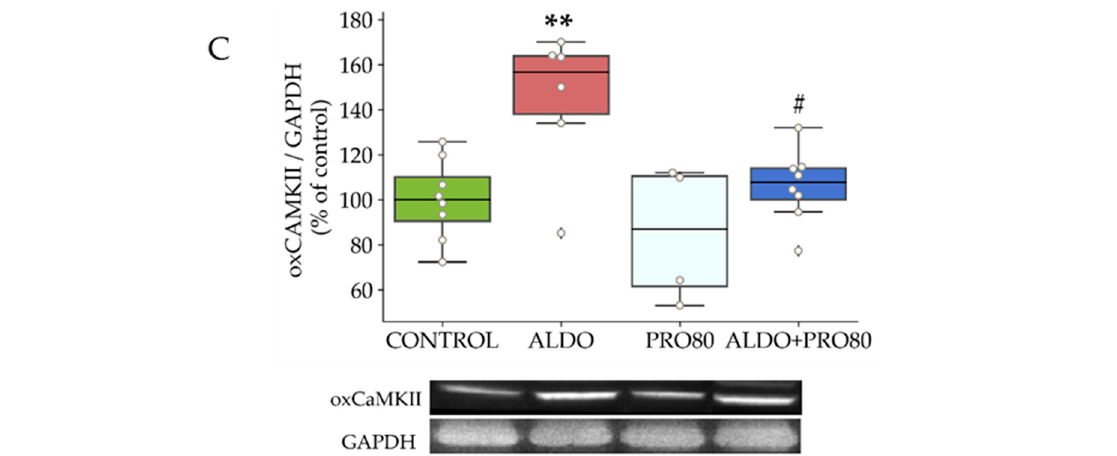
Figure 4. Effect of aldosterone and PRO80 treatment on myocardial protein expression of CAMKII, pCAMKII and oxCAMKII. Relative protein expression levels of Ca 2+ /calmodulin-dependent protein kinase II by western blot. ( A ): Total CaMKII, ( B ): Phosphorylation in threonine 286 (pCaMKII), ( C ): Oxidation in methionines 281 and 282 (oxCAMKII). The boxplots show median, first and third quartile, and minimum and maximum values; the dots show individual values.* p < 0.05 vs. control; ** p < 0.01 vs. control; # p < 0.05 vs. ALDO; ## p < 0.01 vs. ALDO. CONTROL: Control group; ALDO: Aldosterone-salt group; PRO80: Proanthocyanidins-80% enriched extract group; PRO80+ALDO: Aldosterone plus proanthocyanidins-80% enriched extract group ( n = 8).